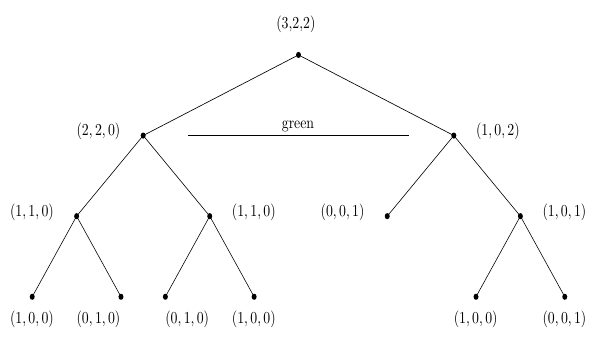
Figure 3: A Huffman labeling of the tree in Figure 2 for a different JL-coloring of K